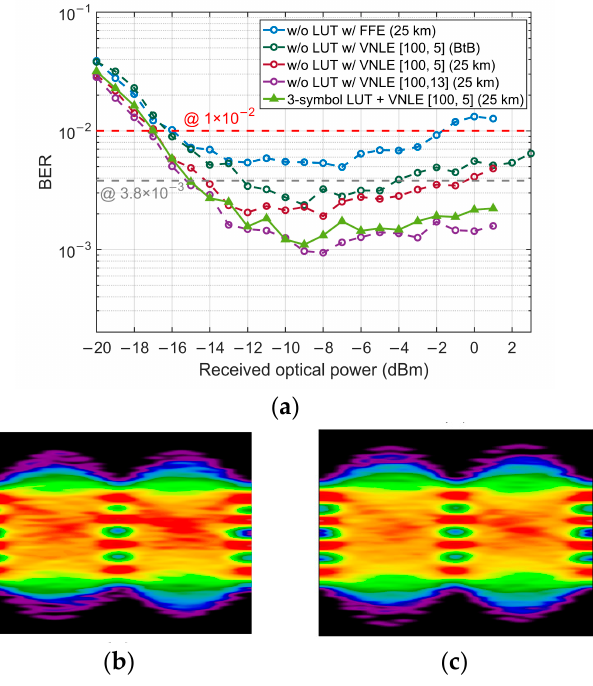
Figure 9. ( a ) BER performance of VNLE only and LUT combined with VNLE; Eye diagrams with VNLE ( L 2 = 5) only ( b ) and with 3-symbol LUT and VNLE ( L 2 = 5) ( c ) at − 3 dBm ROP.